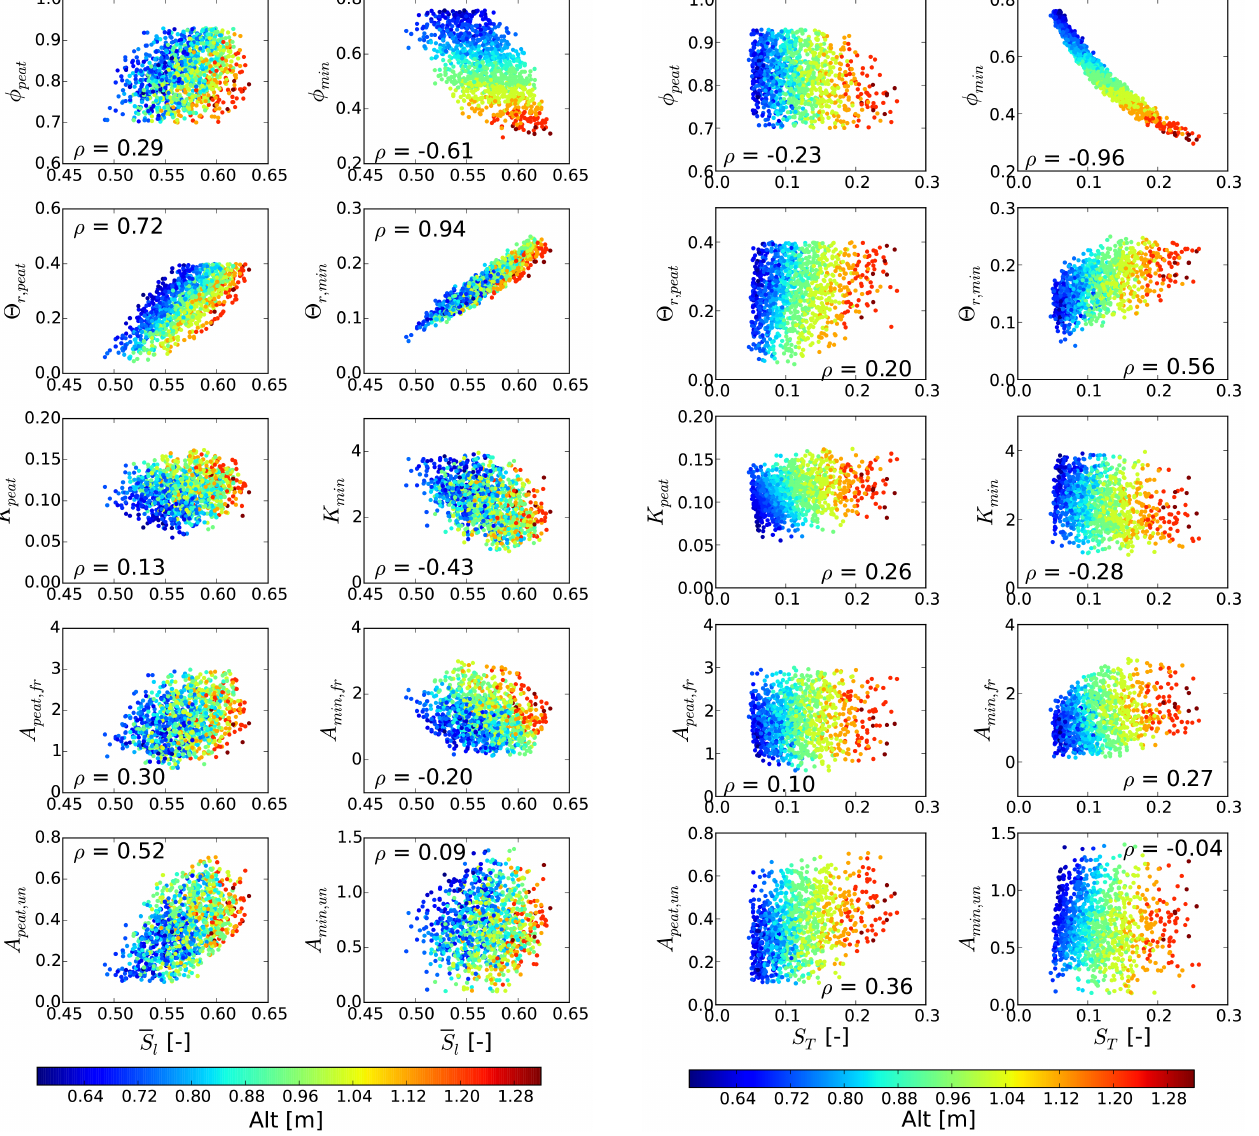
Figure 11. Scatterplots between calibration-constrained parameters and projected annual mean saturation. Soil parameters associated with peat are on the left and with mineral soil on the right (refer to column headings). Colors represent ALT. The associated Pearson correlation coefficient ρ is indicated in each plot.